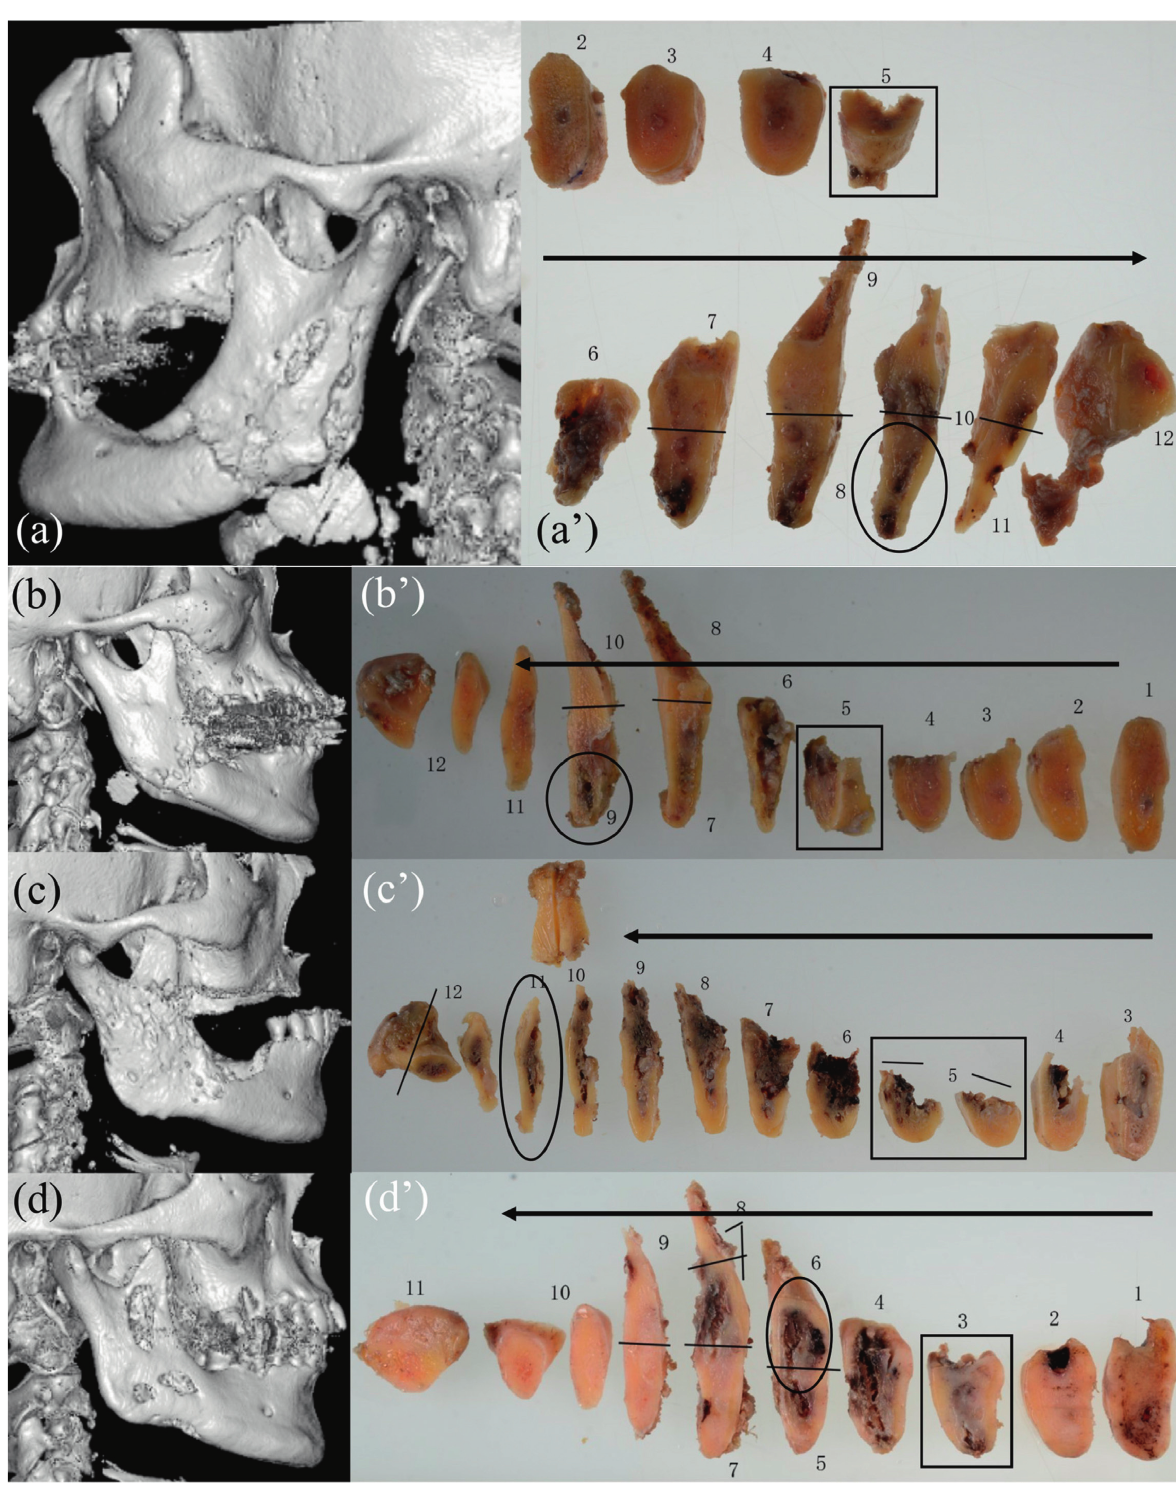
Figure 1: Lateral three-dimensional volume rendering computed tomography images (a–d) and macroscopic images of hemi- mandibulectomy specimens from patients with ORN (a’–d’). Black arrowheads indicate posterior directions. Black box indicates area of intraoral exposed bone. (a) Patient 1. (a’) Black circle indicates macroscopic bone destruction of the medial side of cortical bone near the inferior margin of the mandible. (b) Patient 2. (b’) Black circle indicates bone destruction of the medial side of cortical bone near the mandibular angle. (c) Patient 3. (c’) Black circle indicates bone destruction of the medial side of cortical bone of mandibular ramus. (d) Patient 4. (d’) Black circle indicates apparent bone destruction of the medial and lateral side of cortical bone of mandibular